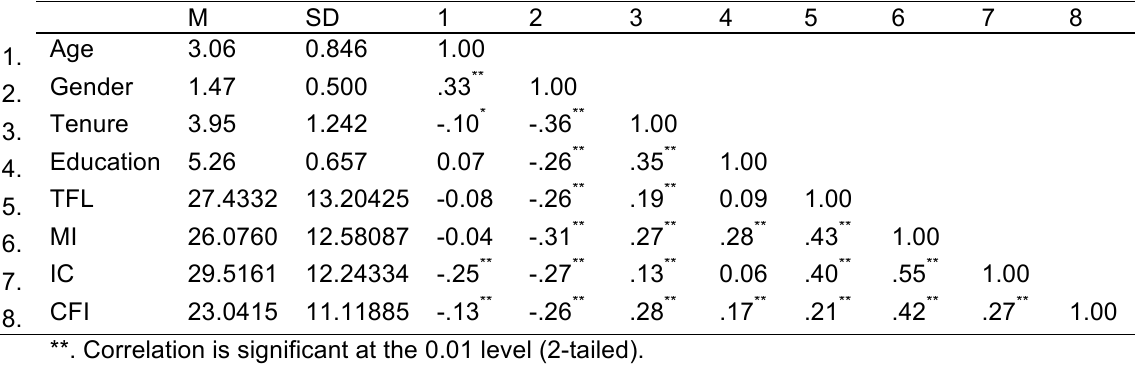
Table 4: Descriptive statistics and inter-correlations